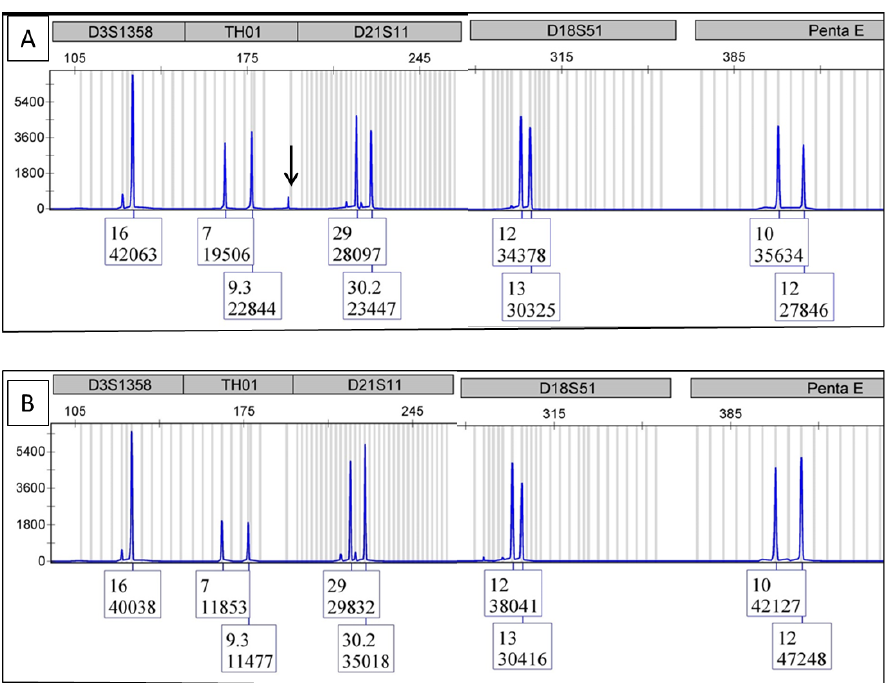
Figure 1. This figure consists of the electropherograms from multiple samples of the same category to protect the DNA fingerprint of any one sample. ( A ) is the DNA fingerprint from the NGS library. The arrow indicates a non-specific peak. ( B ) is the DNA fingerprint from the original sample.